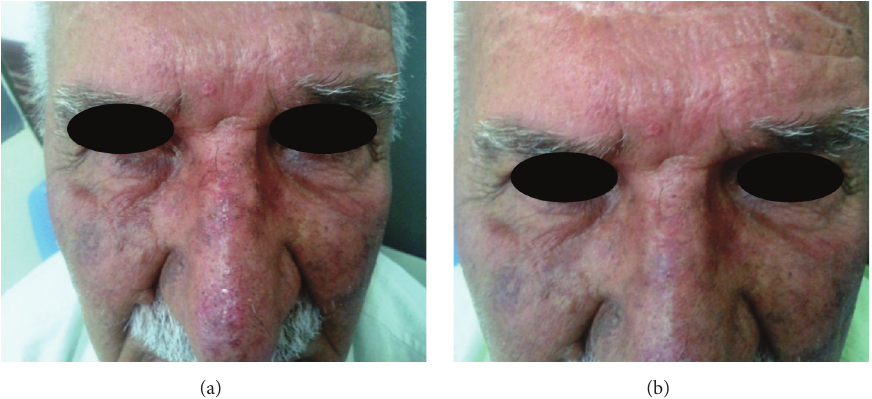
Figure 2: Large AKs on the nose of a participant in the colchicine group (a) at baseline and (b) at the end of the study (8 weeks of treatment).